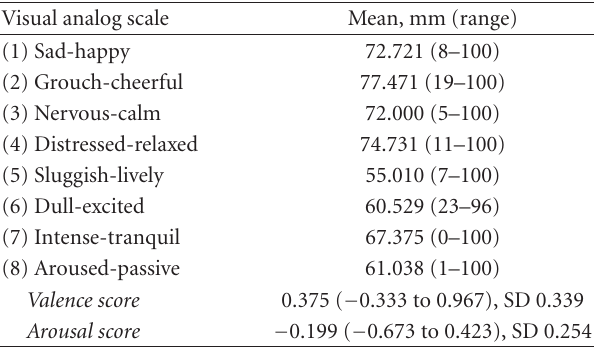
Table 1: Visual analog scale scores for each emotion item